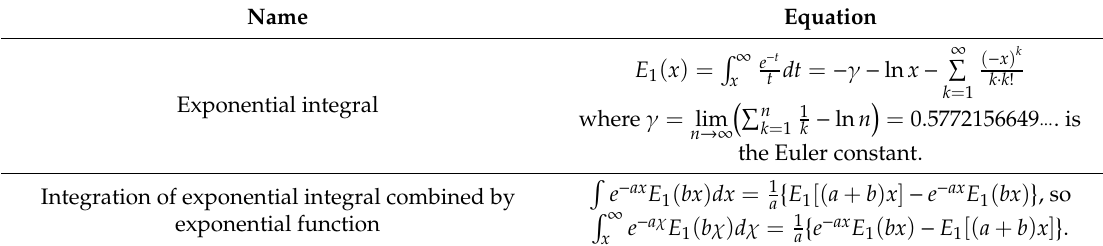
Table A1. Useful formulae about exponential integral to evaluate the